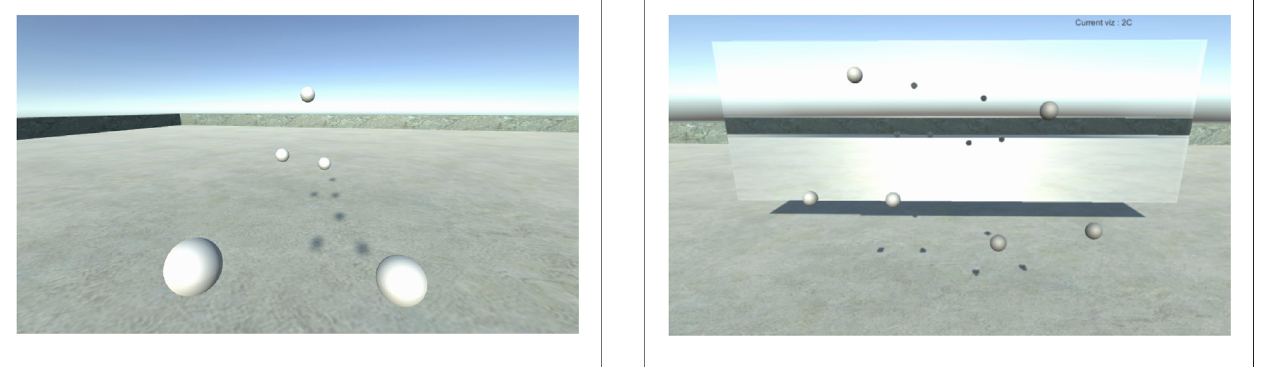
FIGURE 4 | First-person point of view. FIGURE 5 | General point of view of the mirror condition with similar